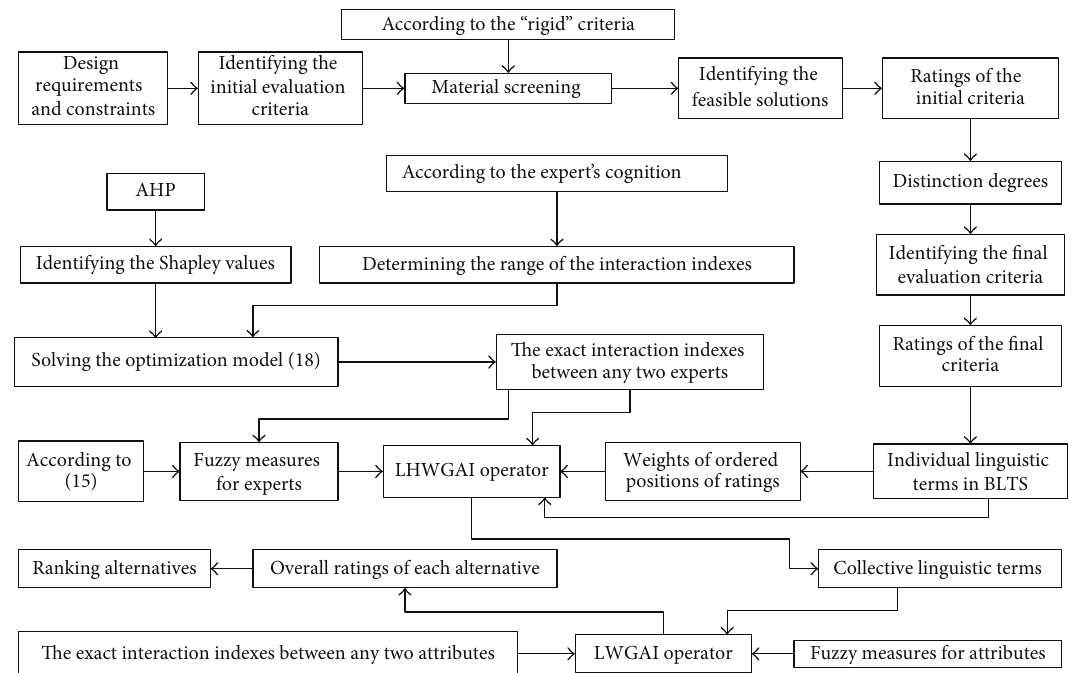
Figure 4: Procedure for phase change material selection.